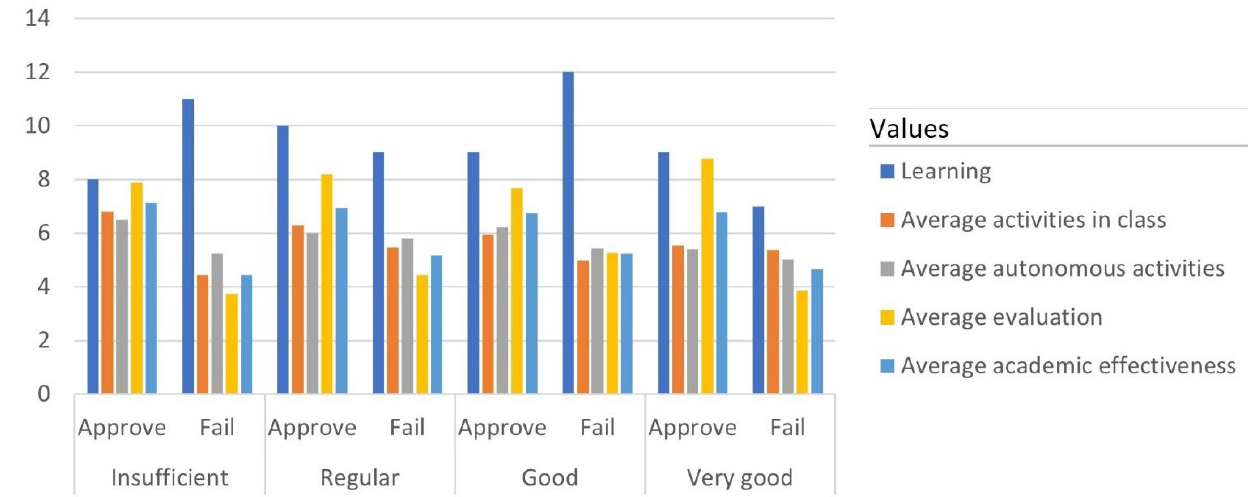
Figure 3. Graph of the trend analysis for the 2020 period.